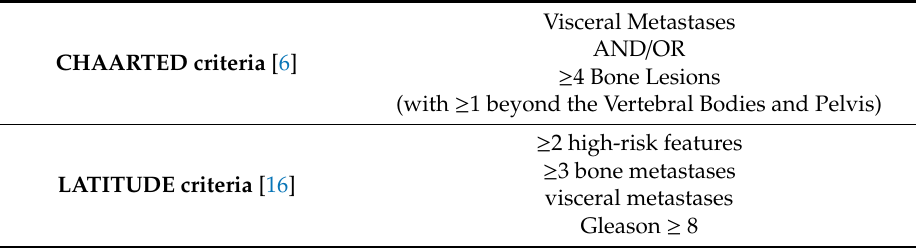
LATITUDE criteria